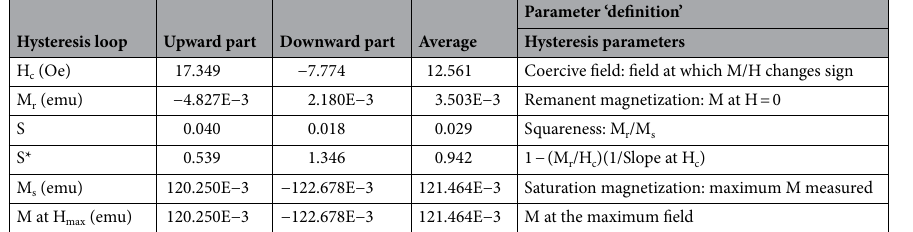
Hysteresis loop Upward part Downward part